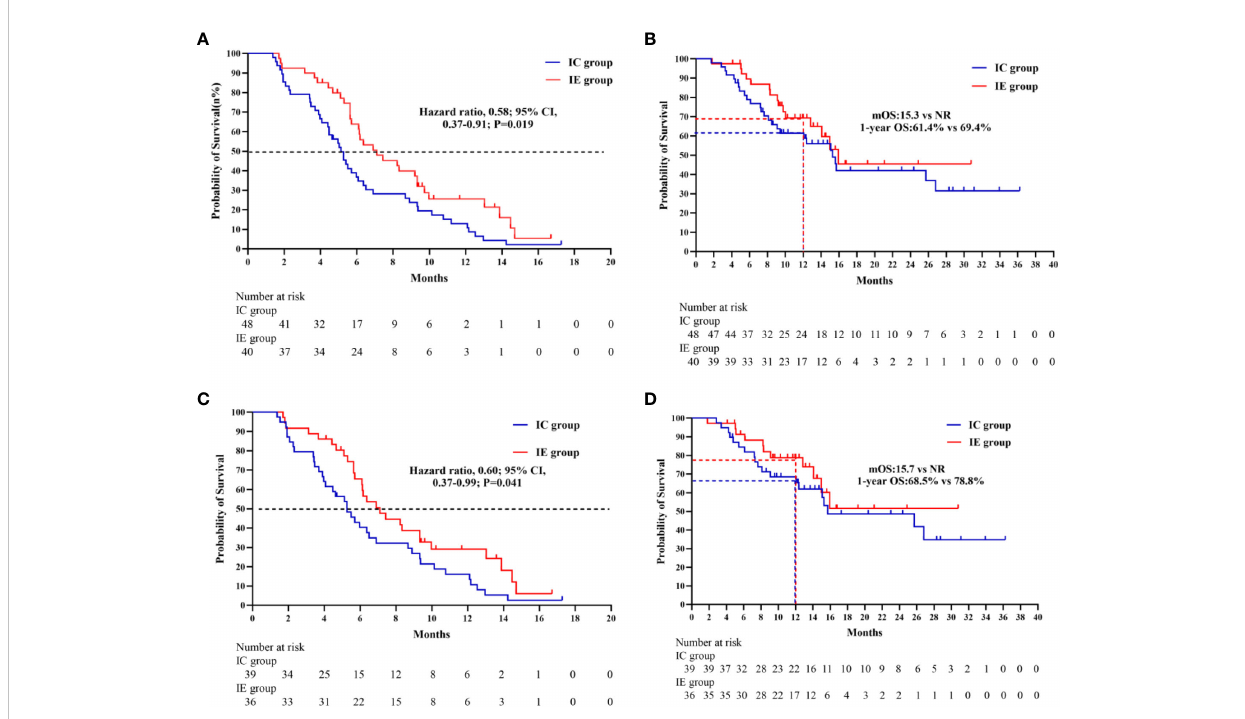
FIGURE 2 (A) Kaplan-Meier survivak curve of progression-free survival comparing IE and IC. (B) Kaplan-Meier survival curve of overall survival comparing IE and IC. (C) Kaplan-Meier survival curve of progression- free survival comparing IE and IC in a sensitivity analysis. (D) Kaplan-Merier survival curve of overall survival comparing IE and IC in a sensitivity